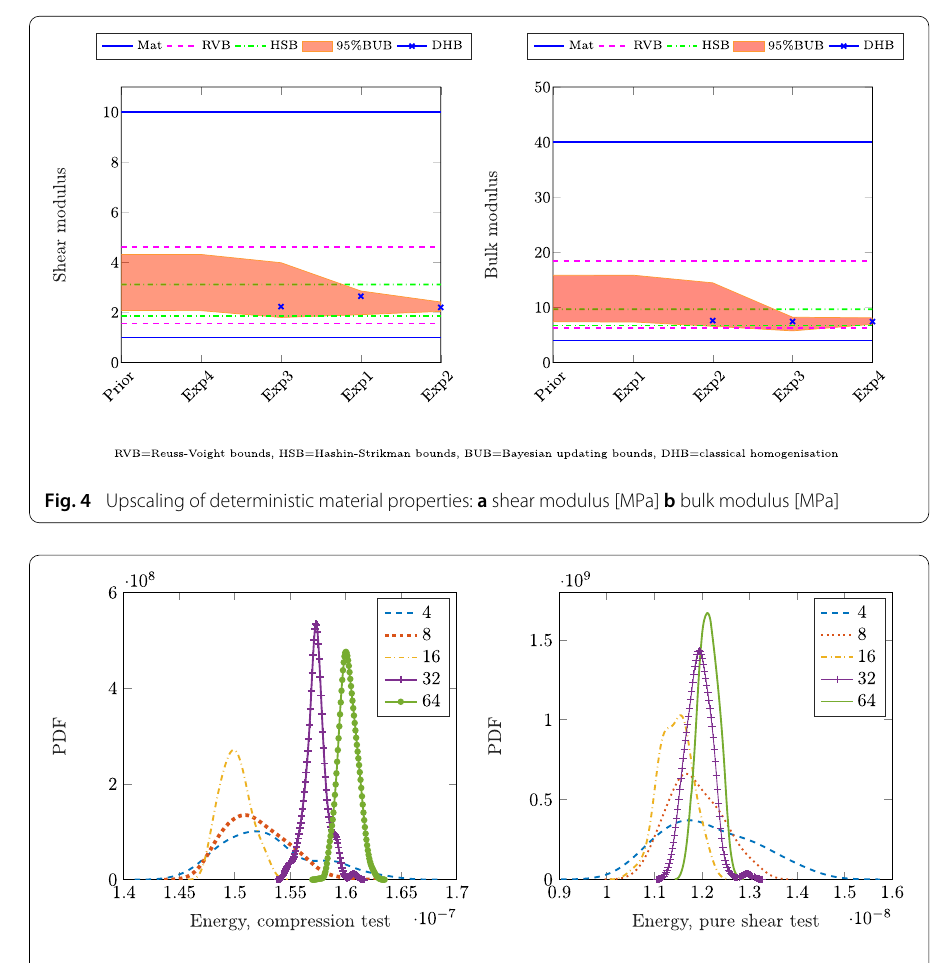
Fig. 5 Measured energy [MJ] on 100 mesostructure realisations for different number of inclusions and random position only. The boundary condition is linear